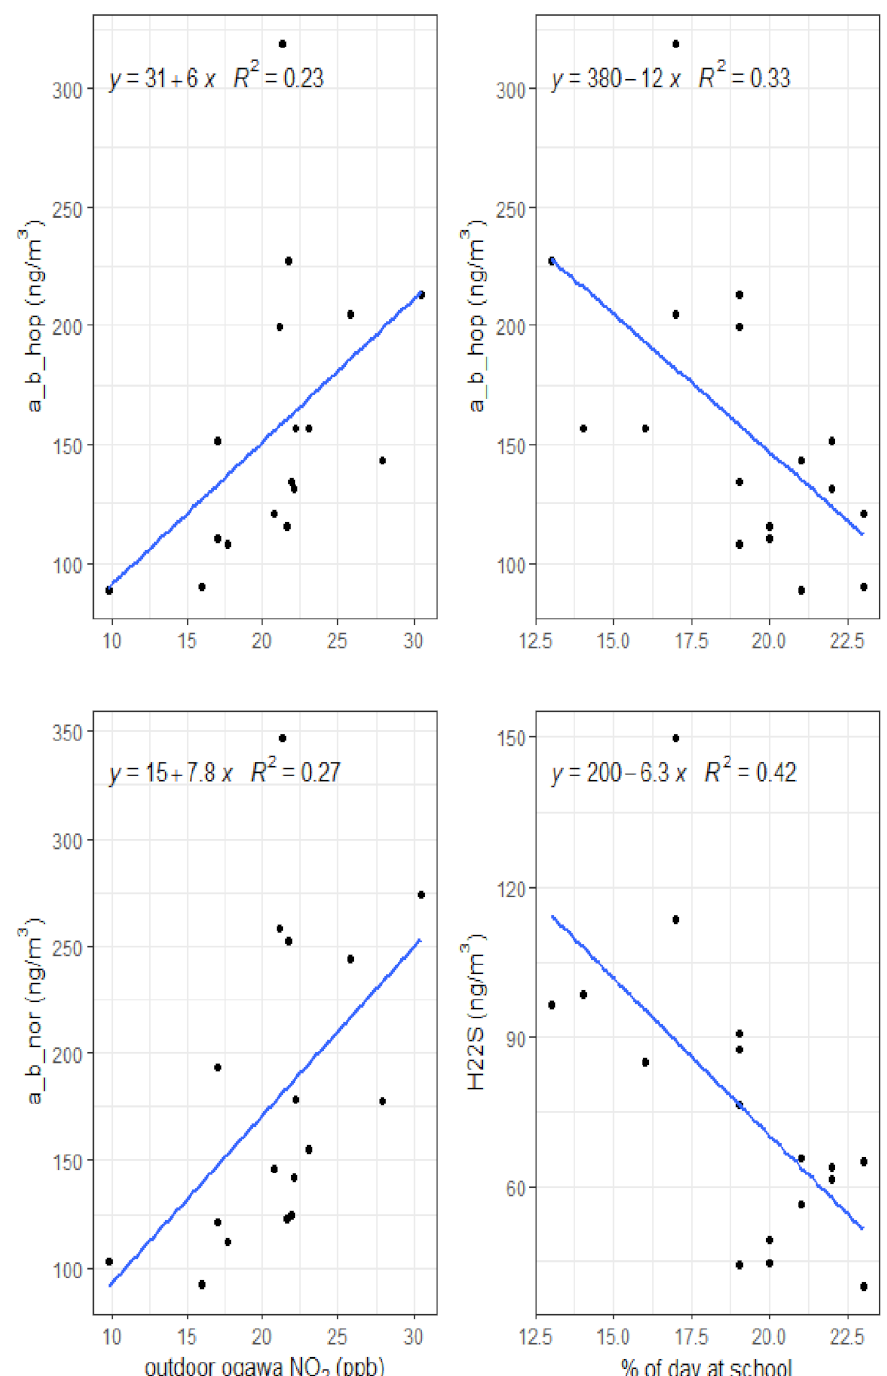
Figure 3. Winter hopanes: LSR models for personal winter hopanes and outdoor NO 2 measured in participant backyards (associated with a_b_hop and a_b_nor) and percent of the day spent at school (associated with a_b_hop and